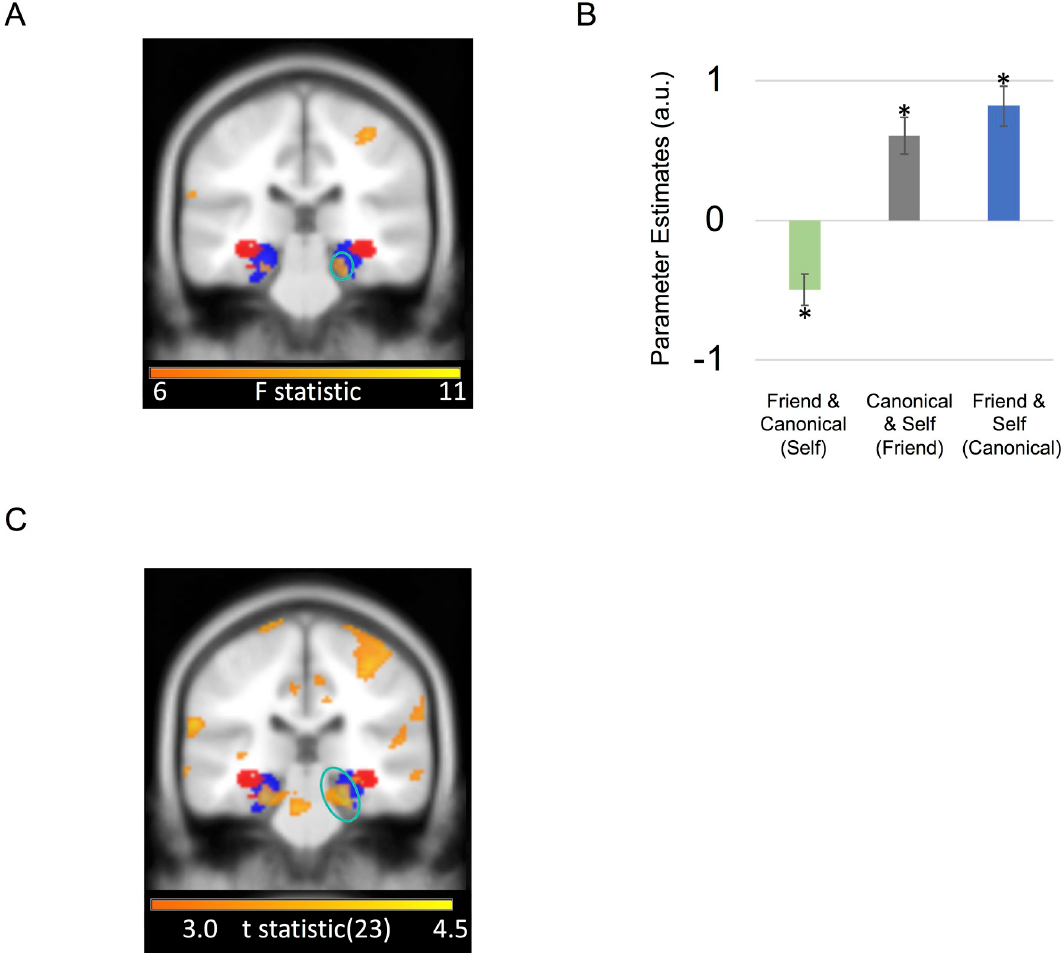
Fig 3. Entorhinal/Subicular choice discrimination effects. A. Coronal image of right entorhinal/subicular region exhibiting an effect of choice discriminability/entropy by condition circled in turquoise. B. Effect size for a 10-mm sphere around right entorhinal/ subicular region exhibiting effect of choice entropy by condition (mean ± SEM). Asterisk marks significance at P < 0.05. See S2 Data for subject data. C. Coronal image showing right entorhinal/subicular (circled in turquoise) correlation with choice entropy for friend and canonical anchor trials (i.e., choices involving self-comparisons) versus self anchor trials (i.e., trials comparing canonical versus friend ratings). Portion of left entorhinal/subicular region showing same effect is also visible. A positive effect size indicates a positive BOLD correlation with choice entropy (i.e., ambiguous choices), whereas a negative effect size indicates a negative BOLD correlation with choice entropy in the same comparison (i.e., straightforward choices). All highlighted regions survived FWE correction for multiple comparisons at P < 0.05 and are displayed at an uncorrected statistical threshold of P < 0.005 for display purposes. For visualization purposes, entorhinal/subicular (blue) and hippocampal body (red) probabilistic masks from the Ju¨lich SPM Anatomy toolbox are presented [28]. BOLD, blood oxygen level-dependent; FWE, family-wise error; SPM, statistical parametric mapping.